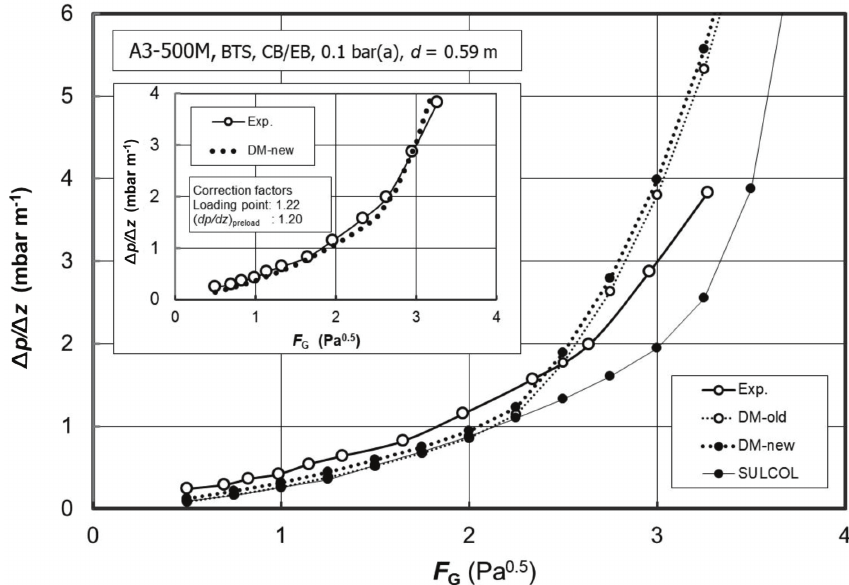
Fig. 13 – Comparison of the specific pressure drop as estimated by original (DM-old) and extended DM (DM-new) for advanced wire gauze corrugated sheet structured pack- ing A3-500M compared with experimental data (BTS, 0.1 bar). SULCOL estimates are related to BXPlus. Inserted graph demonstrates that pressure drop predicted by extended DM utilizing two correction factors, which reflect the extent of deviation in this case, perfectly matches with